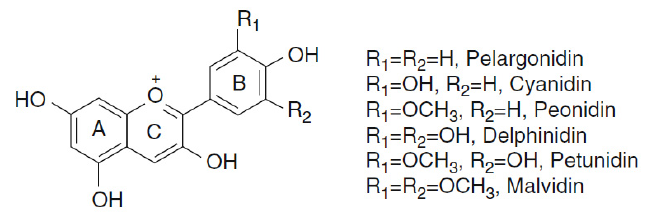
Figure 7. Chemical structures of anthocyanidins.